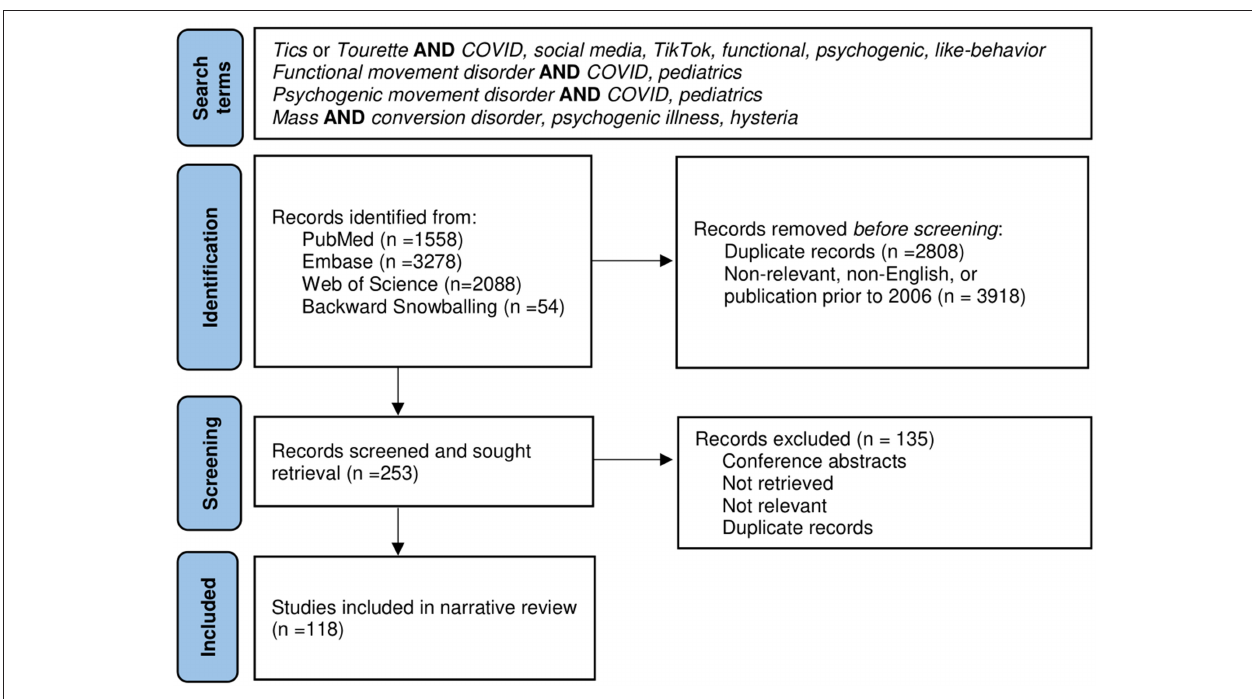
FIGURE 1 | Modified Patient Reporting Items for Systematic Reviews and Meta-Analyses (PRISMA)